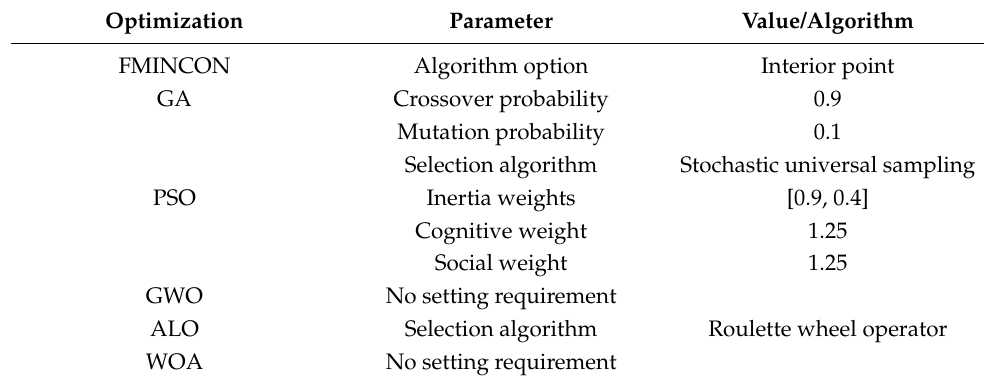
Figure 8. Equal loading of generators and corresponding fuel consumption. Table 1. Parameter settings for the optimization algorithms.